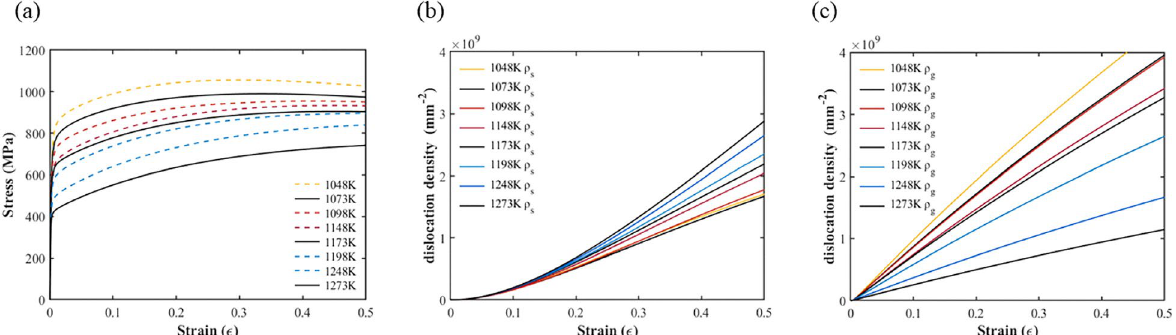
Figure 8. Predicted mechanical behavior of CoCrFeMnNi alloys at different annealing temperatures: ( a ) stress- stain curves; ( b ) statistical storage dislocation density evolutionary curves; and ( c ) geometrically necessary dislocation density evolutionary